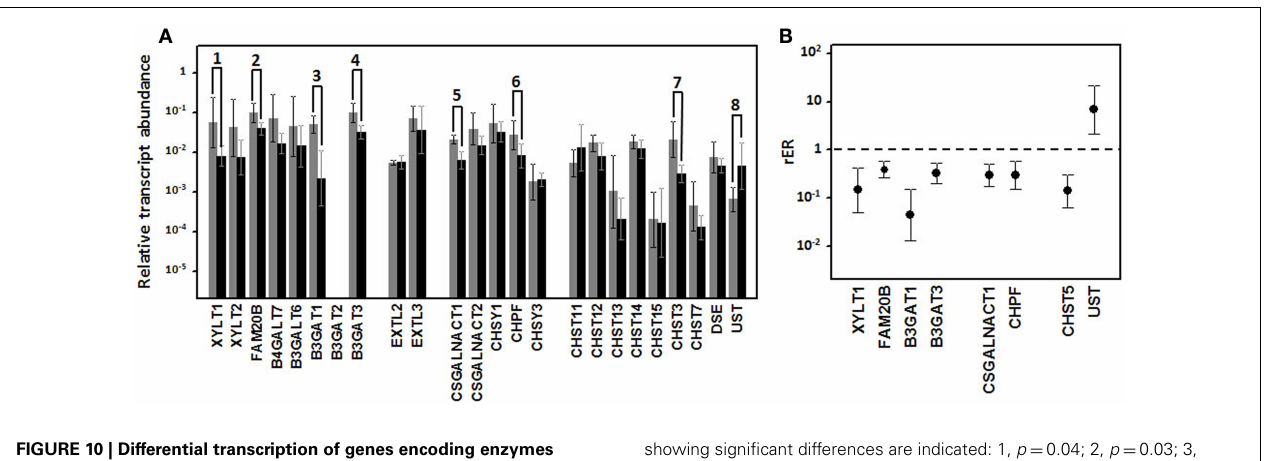
FIGURE 10 | Differential transcription of genes encoding enzymes involved in the biosynthesis of CS repeating unit . (A) Relative transcript abundance of mRNAs for CS biosynthesis. Relative abundance for well-differentiated lung NETs (gray bars) and poorly differentiated lung NETs (black bars) are plotted on a log scale for each gene assayed and spread represents standard deviation. Genes